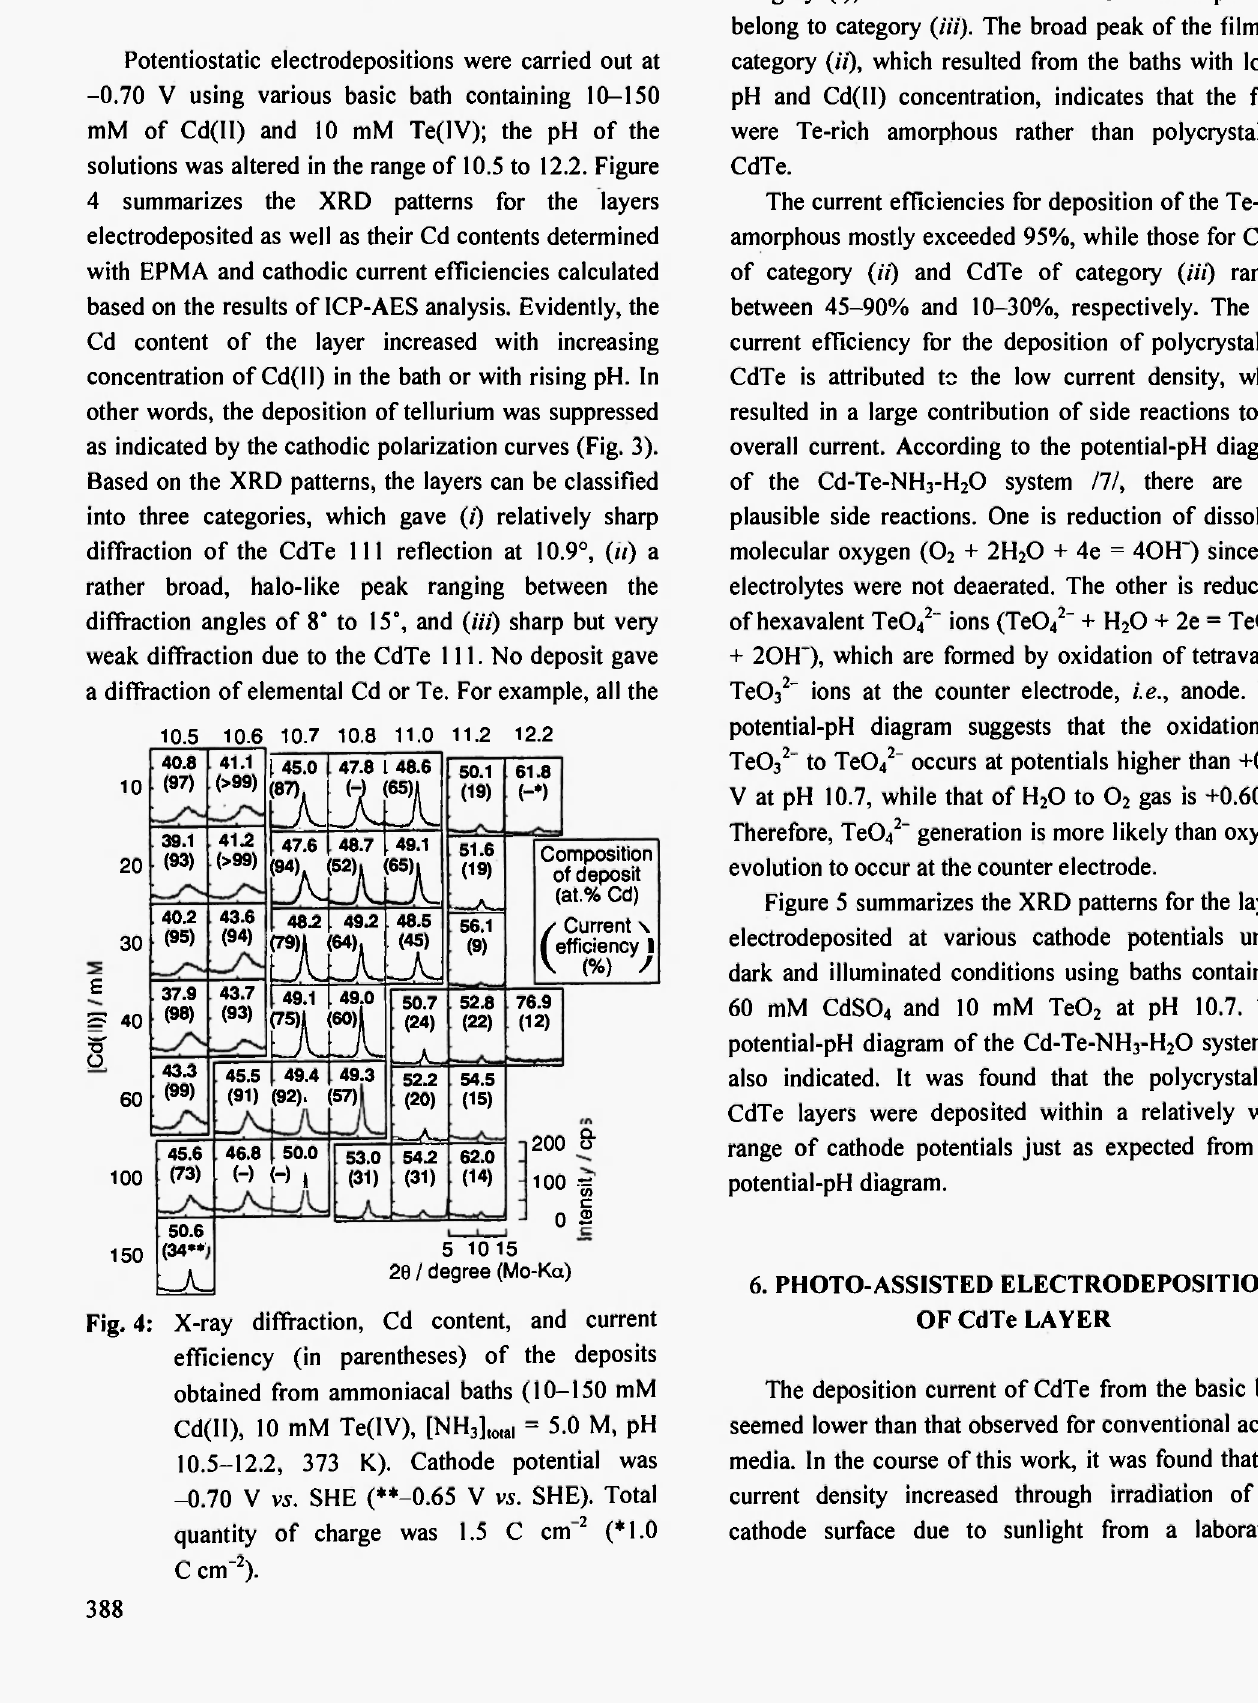
Fig. 4: X-ray diffraction, Cd content, and current efficiency (in parentheses) of the deposits obtained from ammoniacal baths (10-150 mM Cd(II), 10 mM Te(IV), [NH 3 ] t01al = 5.0 M, pH 10.5-12.2, 373 K). Cathode potential was -0.70 V vi. SHE (**-0.65 V vs. SHE). Total quantity of charge was 1.5 C cm" 2